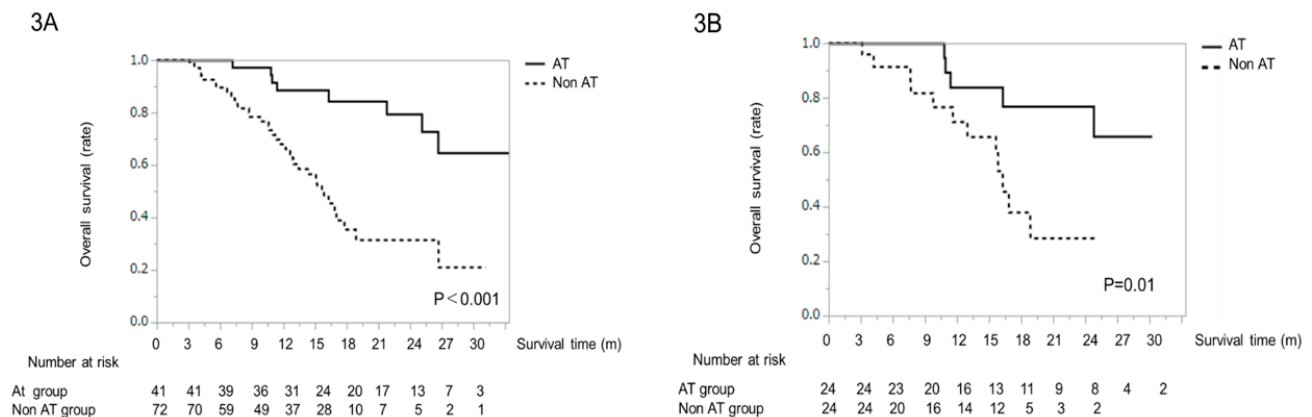
Figure 3. ( A ) Overall survival time in patients treated with lenvatinib (LEN), before propensity matching score (PSM) analysis. Kaplan–Meier curves of overall survival for the alternating LEN and trans-arterial therapy (AT, solid line) and non-AT (dotted line) groups. ( B ) Overall survival time in patients treated with LEN, after PSM analysis. Kaplan–Meier curves for overall survival for the AT (solid line) and non-AT (dotted line) groups.